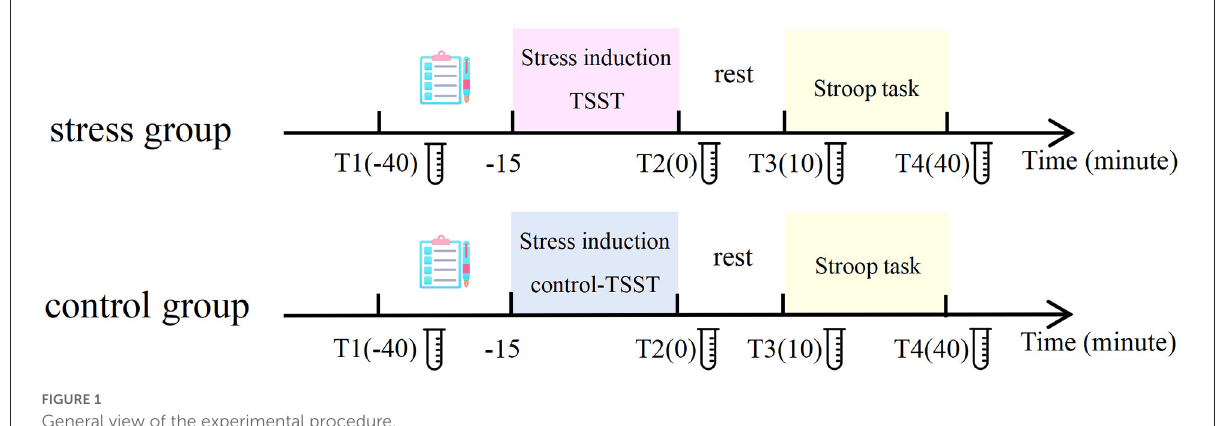
FIGURE1 General view of the experimental